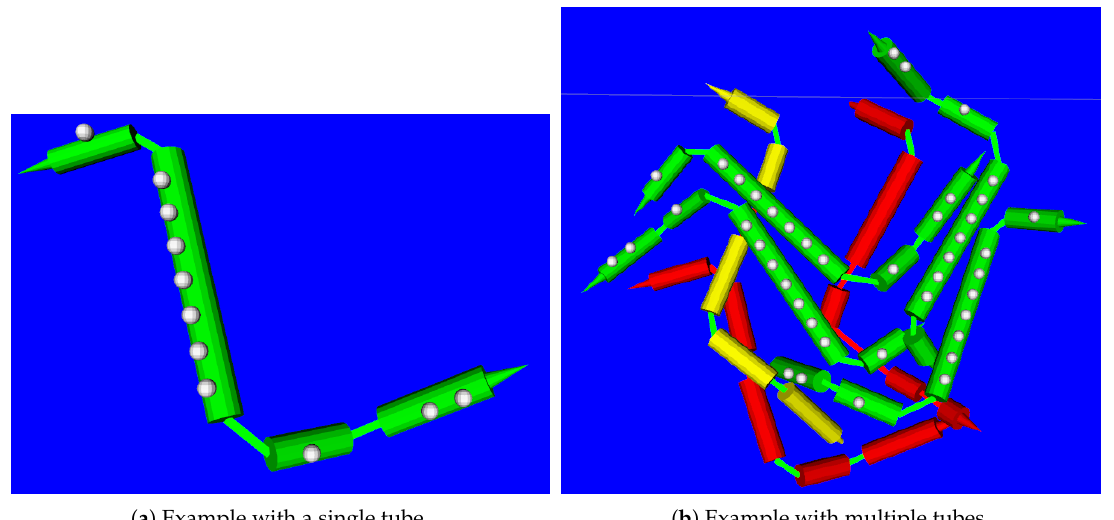
Figure 2. Examples of grasping points on tubes Figure 5. Examples of grasping points on